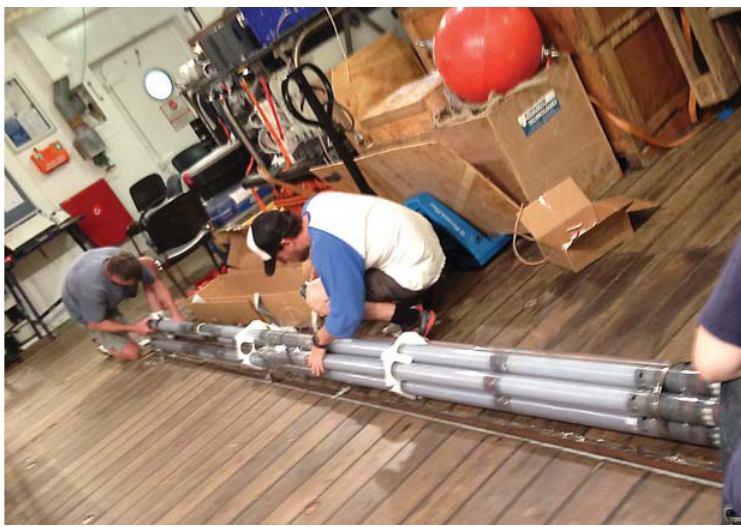
Figure 5. The downhole instrument package is fabricated before connecting it to the intake and ropes that space the package at the proper depth in the borehole. Seven osmotic packages are arranged in a